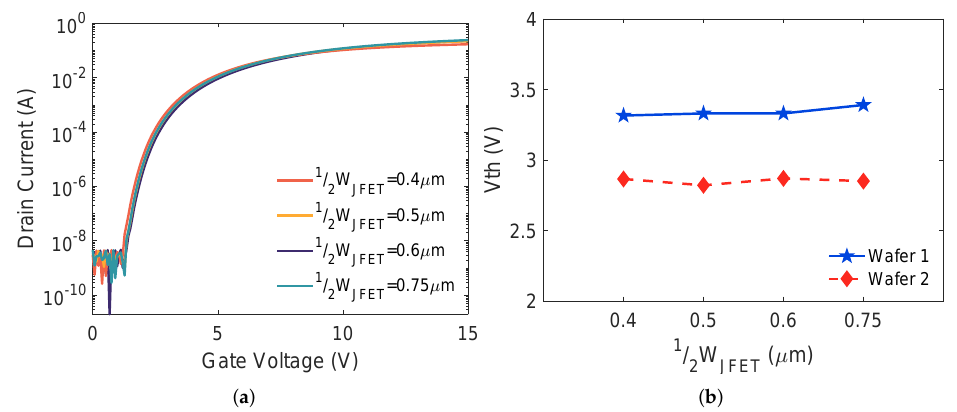
Figure 3. ( a ) Measured transfer characteristics of the packaged 650V SiC MOSFETs on wafer 1 and ( b ) V th variation as a function of 1 W JFET for MOSFETs on wafers 1 and 2. 2